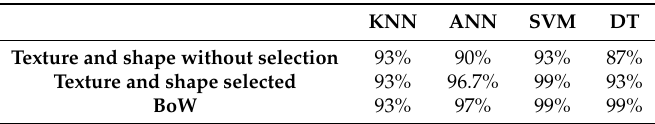
Table 12. Correct classification rate (CCR%) of breast mass based on our texture and shape features with and without selection process, and our BoW